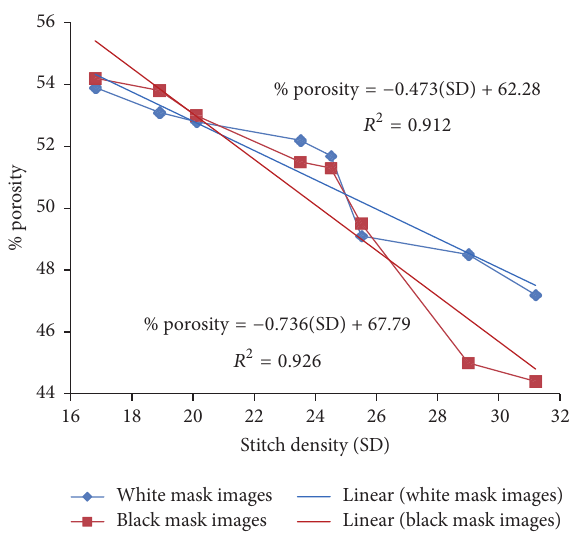
White mask images Linear (white mask images) Black mask images Linear (black mask images) Figure 12: % porosity against SD for CKM.